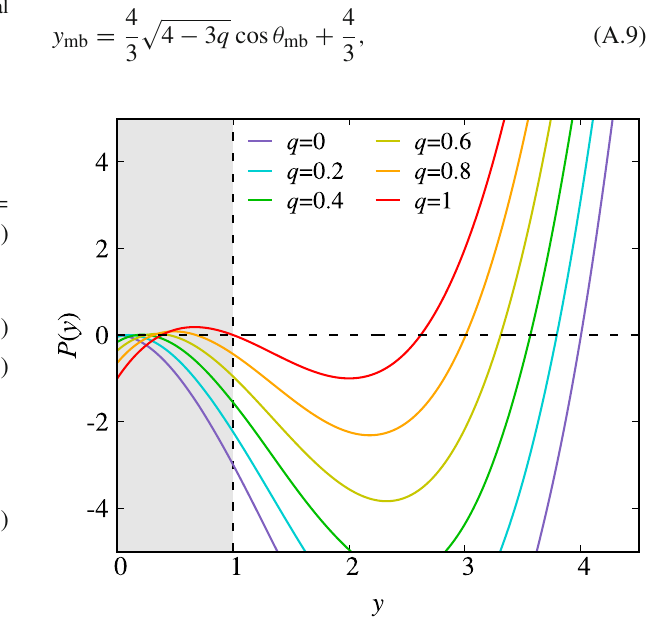
Fig. 7 Curves of P ( y ) with various q against y and the shadowed region represents the unallowed range of y for the marginally bound orbit from the condition Eq.